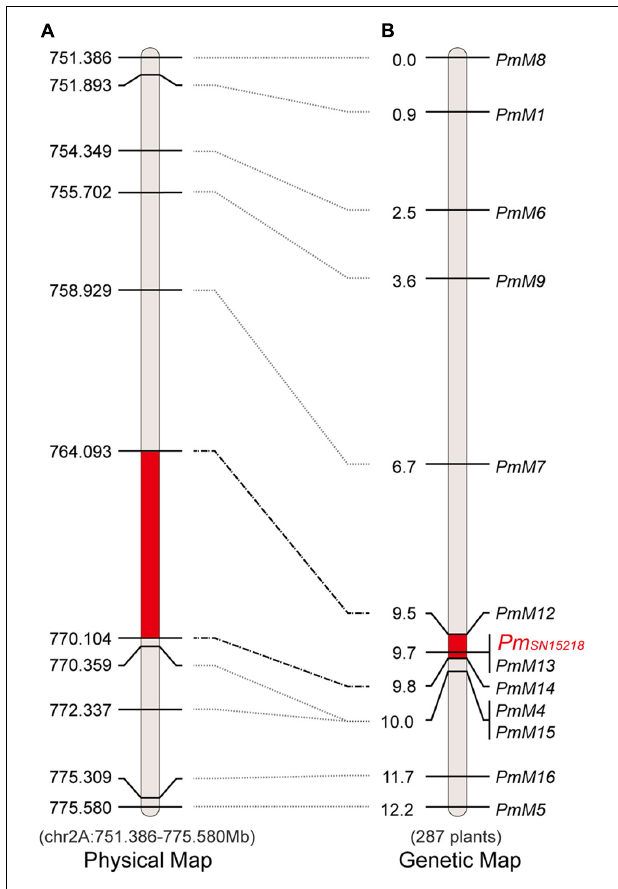
FIGURE 3 | Physical and genetic map of Pm SN 15218 region. (A) Physical map of chromosome 2AL 751.4–775.6 Mb. (B) The precision genetic map with 287 F 2 individuals. The map units were physical positions (Mb) or centimorgan (cM) that was labeled on the left sides of the